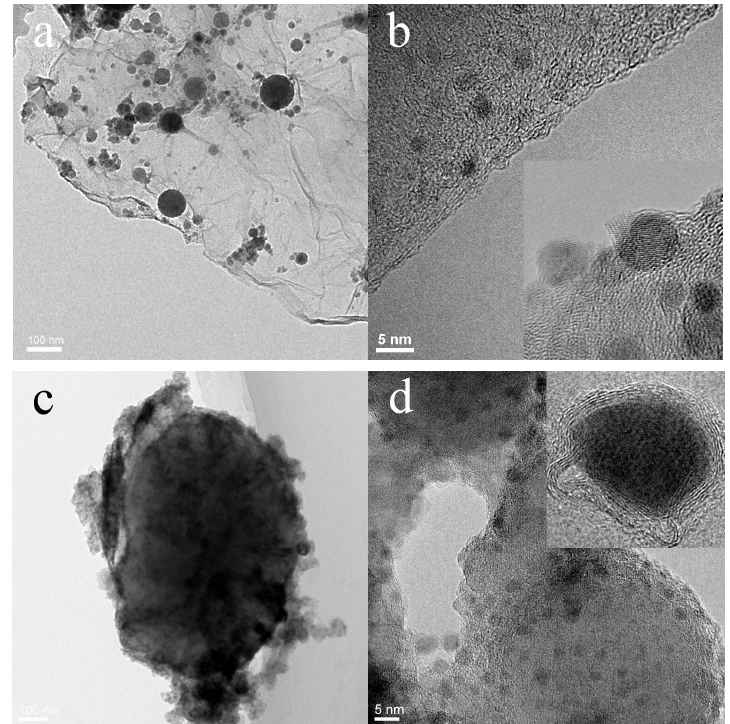
Figure 4. Typical and high-resolution transmission electron microscopy (TEM) images of the recovered samples. TEM image ( a ) and high-resolution TEM image ( b ) of sample No. 1. TEM image ( c ) and high-resolution TEM image ( d ) of sample No. 3.